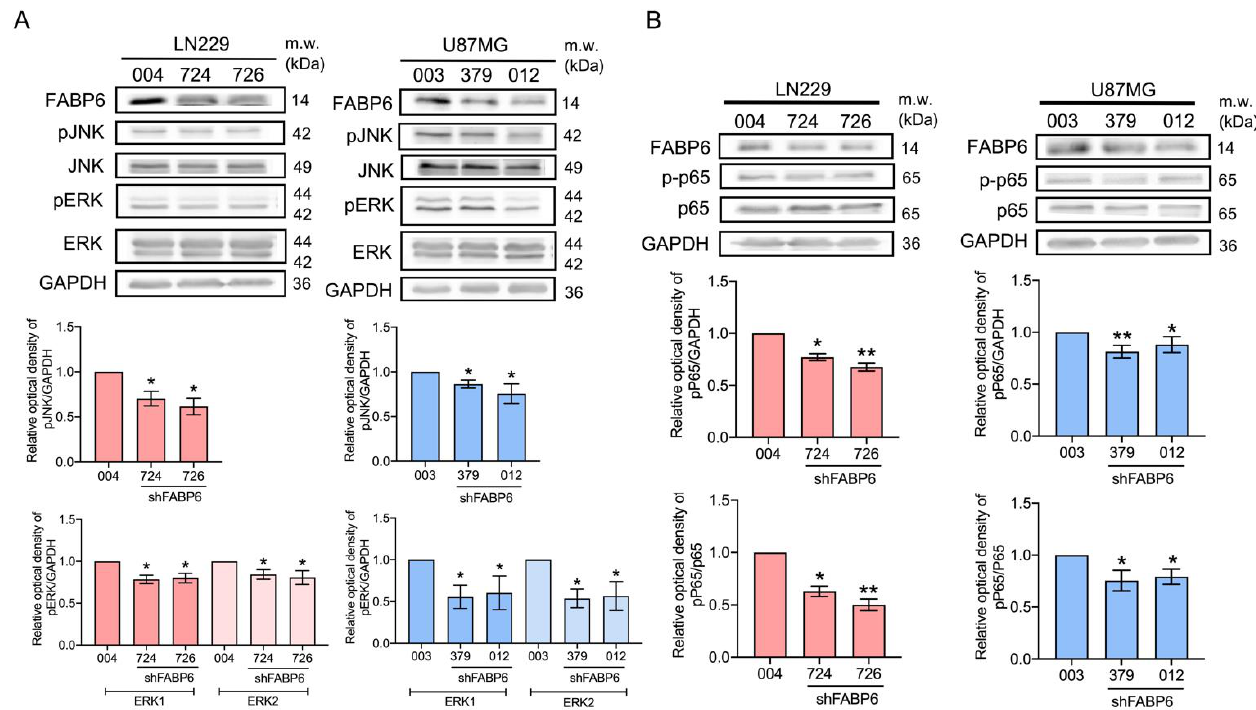
Figure 6. Effects of c-Jun NH2-terminal kinase (JNK), extracellular signal-regulated kinase (ERK), and p65 after FABP6 knockdown. The expression levels of phospho-c-Jun NH2-terminal kinase (p-JNK), JNK, phospho-extracellular signal- regulated kinase (p-ERK), ERK ( A ), phospho-p65 (p-p65), and p65 ( B ) were analyzed by Western blotting in the LN229 and U87MG cells using the shScramble control group and shFABP6. GAPDH was used as the loading control. The plotted graphs show the relative quantitative analysis of the aforementioned proteins. * p < 0.05 and ** p < 0.01 compared with the shScramble control group.